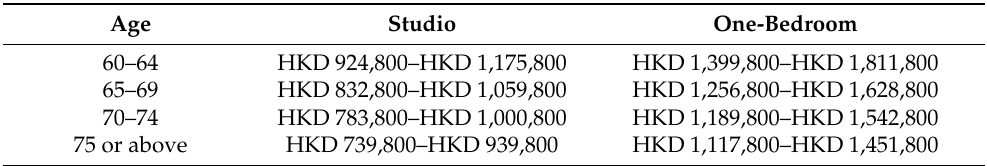
Table 1. Required contribution for Cheerful Court (Adapted from Ref. [83]. 2020, Hong Kong Housing